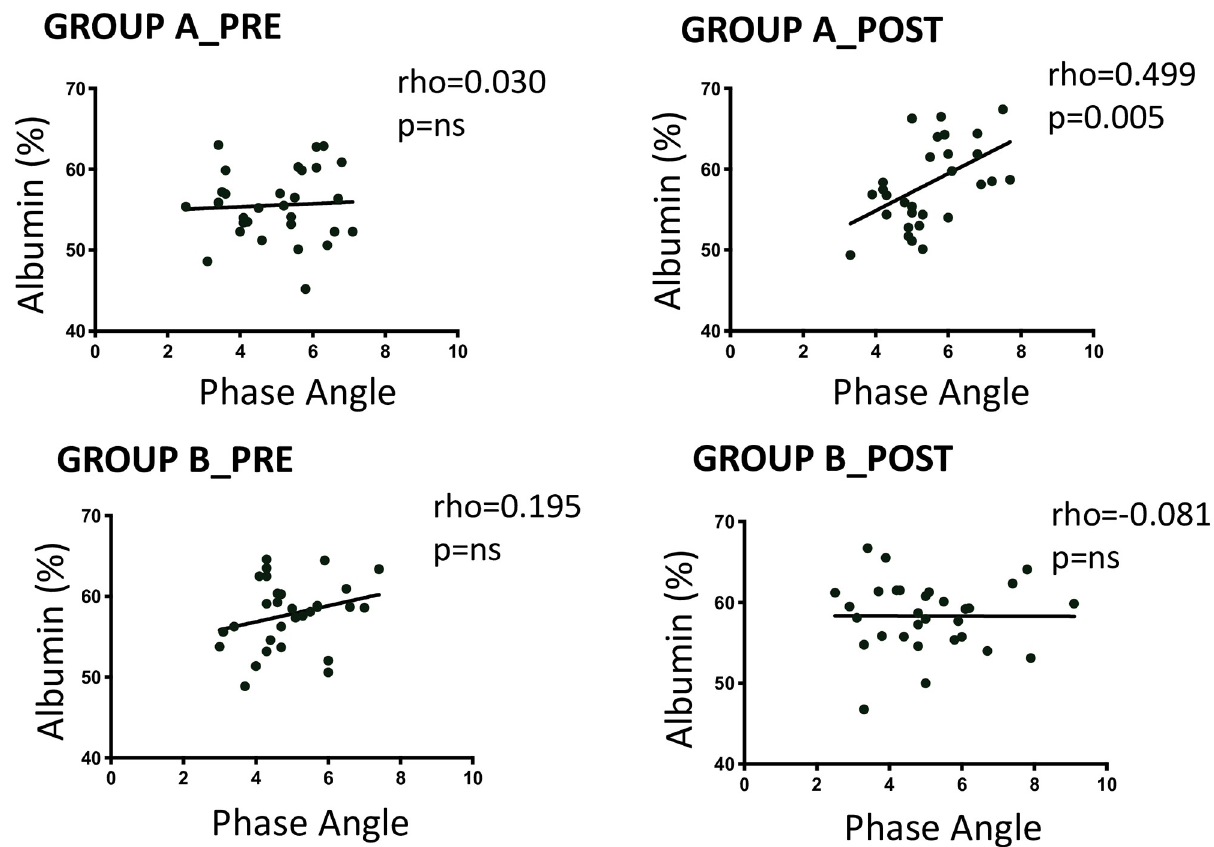
Fig 3. Correlation between baseline levels of phase angle (PA) and albumin (%) in Group A e B, pre and post, PESF or not. Spearman correlation coefficient and p-value are reported.